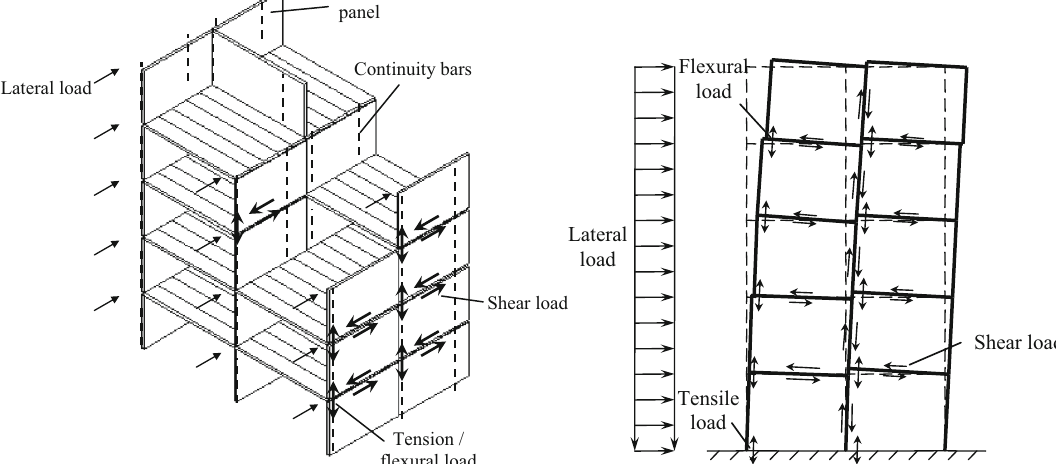
Fig. 4 Tensile, shear and flexural loads acting on the grouted splice connection of a precast concrete wall frame system as a result of the lateral load (Ling 2011).